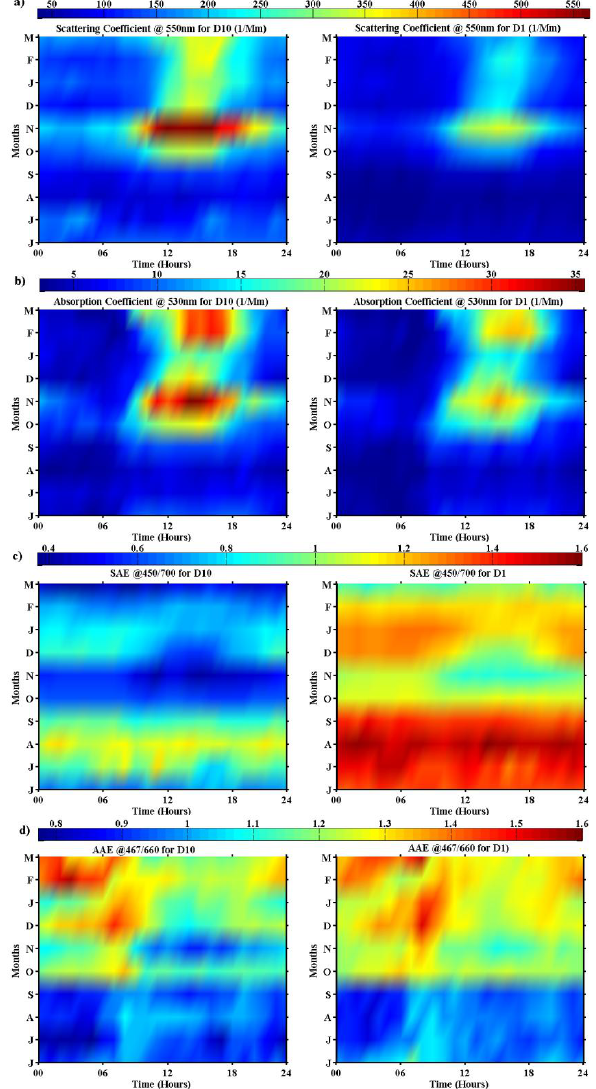
Figure 7. Monthly-mean diurnal variation of (a) scattering coeffi- cient, (b) absorption coefficient, (c) scattering Ångström Exponent (SAE) and (d) absorption Ångström Exponent (AAE) for D 10µm and D 1µm size